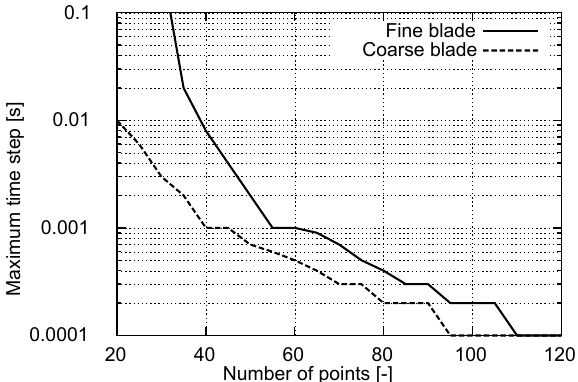
Figure 7. Maximum stable time step depending on the number of points for the coarse and fine blade geometries of the NREL 5MW reference turbine. The points are distributed using a full cosine dis- tribution (Pirrung et al., 2012). The results are obtained through a numerical